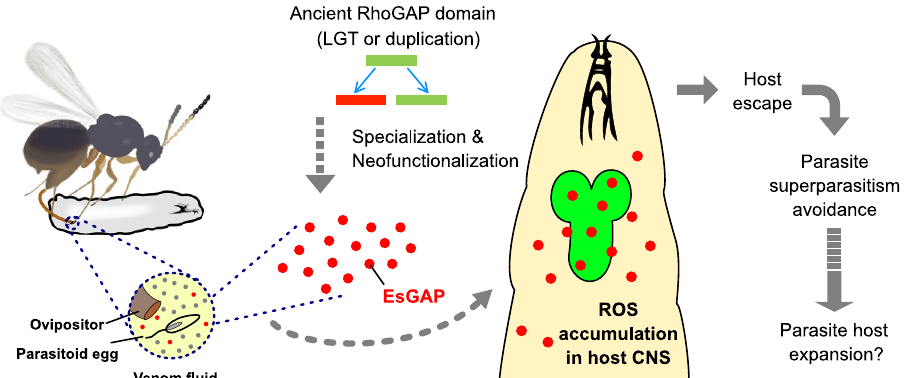
Fig. 6 The proposed evolutionary scenario of superparasitism avoidance in Leptopilina . EsGAP proteins are injected into the host along the parasitisation of Leptopilina wasps. The gene encoding this type of proteins was ancestrally originated, from either lateral gene transfer (LGT) from distantly related species or the duplication event of existed paralogs. Since the acquisition, this gene experienced further duplication and rapid evolution. Of duplicated copies, the ones (red) of expression specialisation in the venom were ultimately neofunctionalized. Injected EsGAP proteins induce the ROS accumulation in the host CNS that leads to the escape behaviour of hosts. Through manipulating the escape behaviour of parasitized hosts, parasitoids avoid superparasitism and intraspeci fi c competition. As a long-term effect, intraspeci fi c competition might lead to increased resource use diversity (see refs. 76 – 78 and our ‘ Discussion ’ ). The images were crafted using Af fi nity Designer v1.8.6 and Procreate